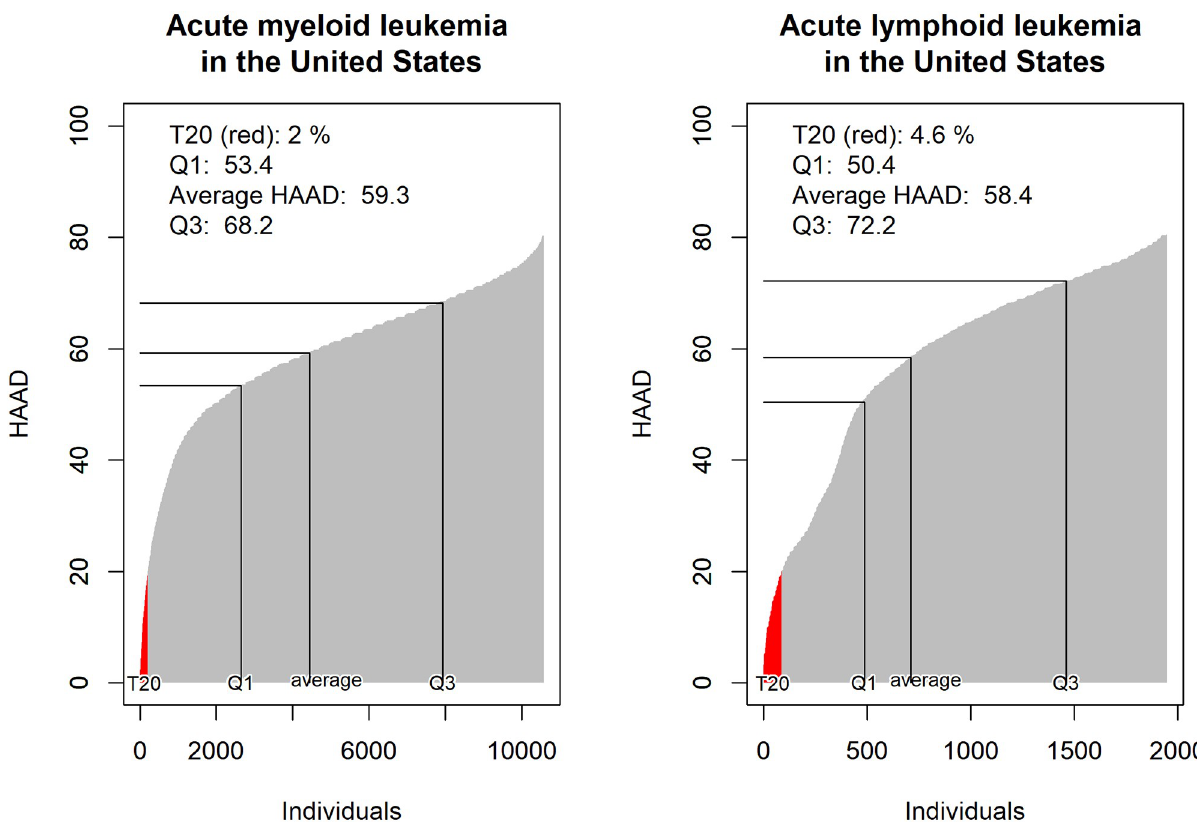
Fig 4. Estimated distribution of Health Adjusted Age at Death (HAAD) in the United States in 2017. Left: Acute myeloid leukemia (AML). Right: Acute lymphoid leukemia (AML).